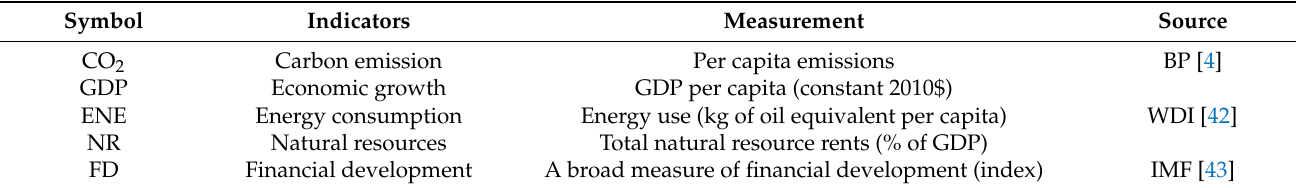
Table 1. Details of the dataset